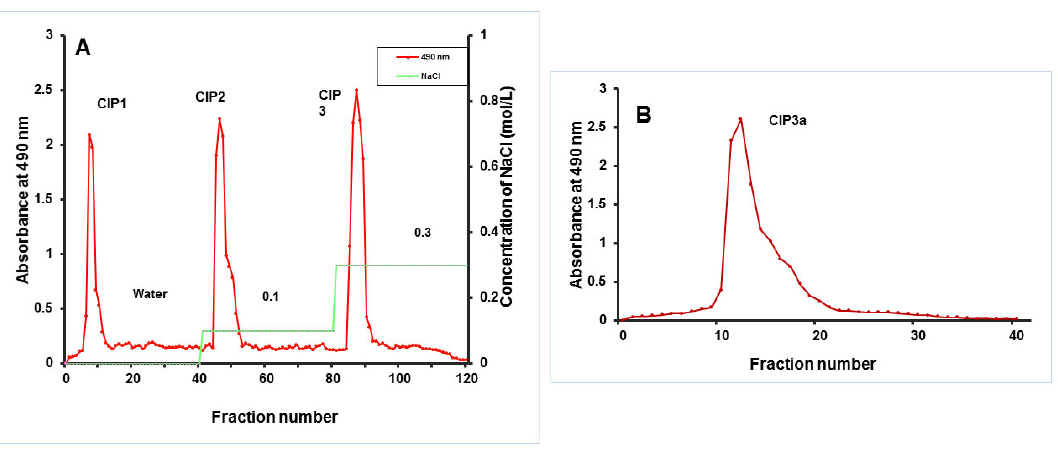
Figure 3. ( A ) Elution profiles of crude CIP on a column of DEAE-cellulose, obtaining fractions CIP1, CIP2 and CIP3; ( B ) Elution profile of CIP3a on Sephacryl 6B column.